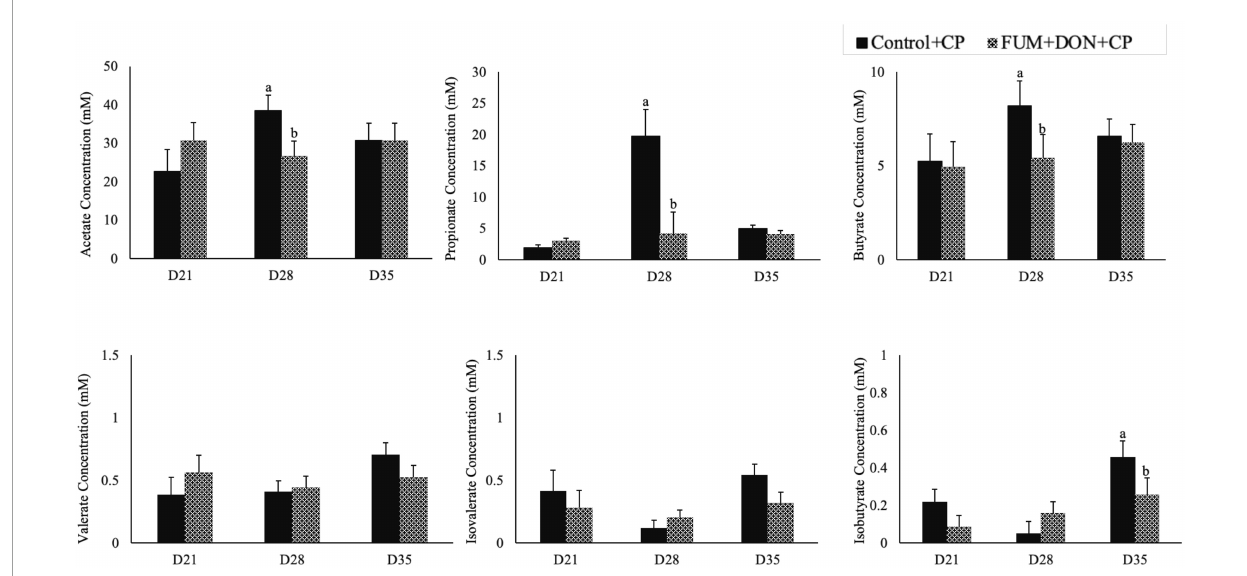
FIGURE8 Effect of subclinical fumonisins (FUM) and deoxynivalenol (DON) contamination on of short chain fatty acids (SCFA). Broilers were fed control or mycotoxin (FUM 3 mg/kg diet + DON 4 mg/kg diet). All birds received 1 × 10 8 CFU/bird of C. perfringens on d 19 and 20. Cecal digesta was analyzed SCFA at 1, 7, and 14 days post-infection. Bars (+SEM) with “a” and “b” superscripts indicate statistical differences within an age ( P <